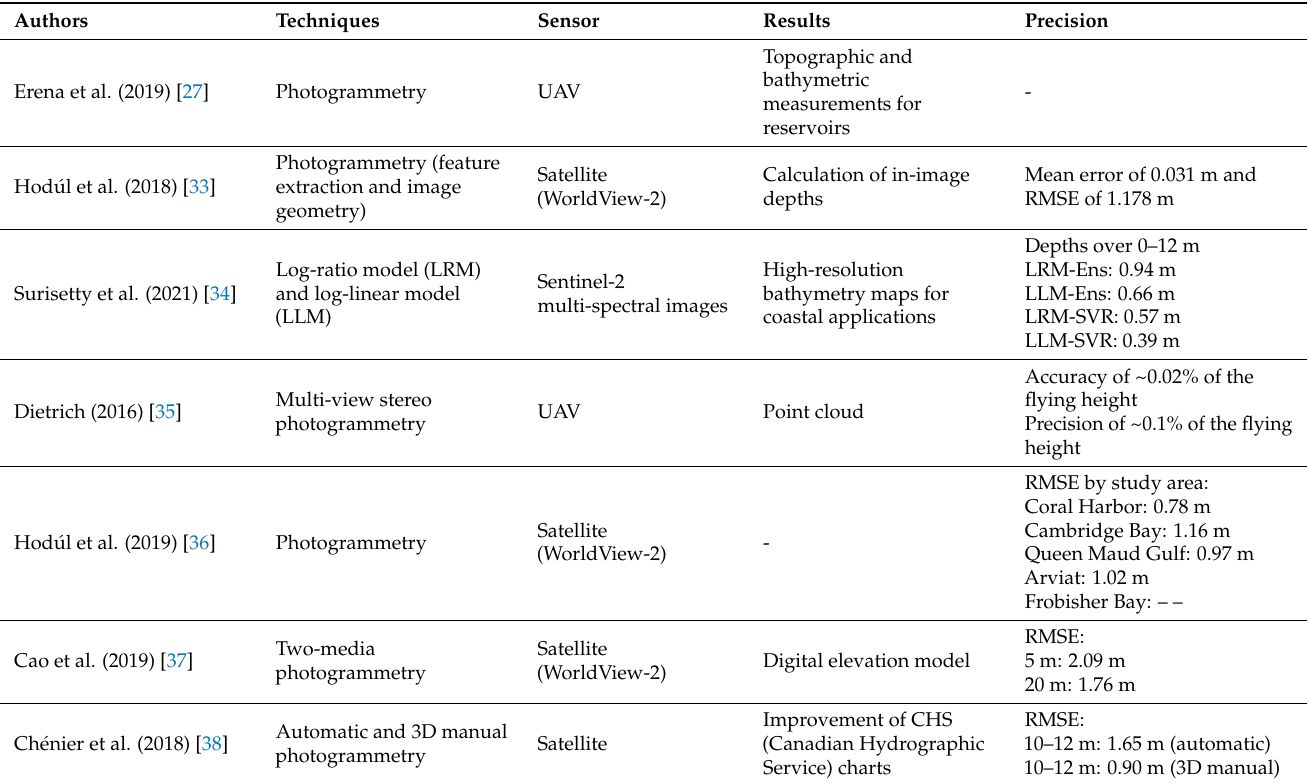
Table 1. Summary of previous